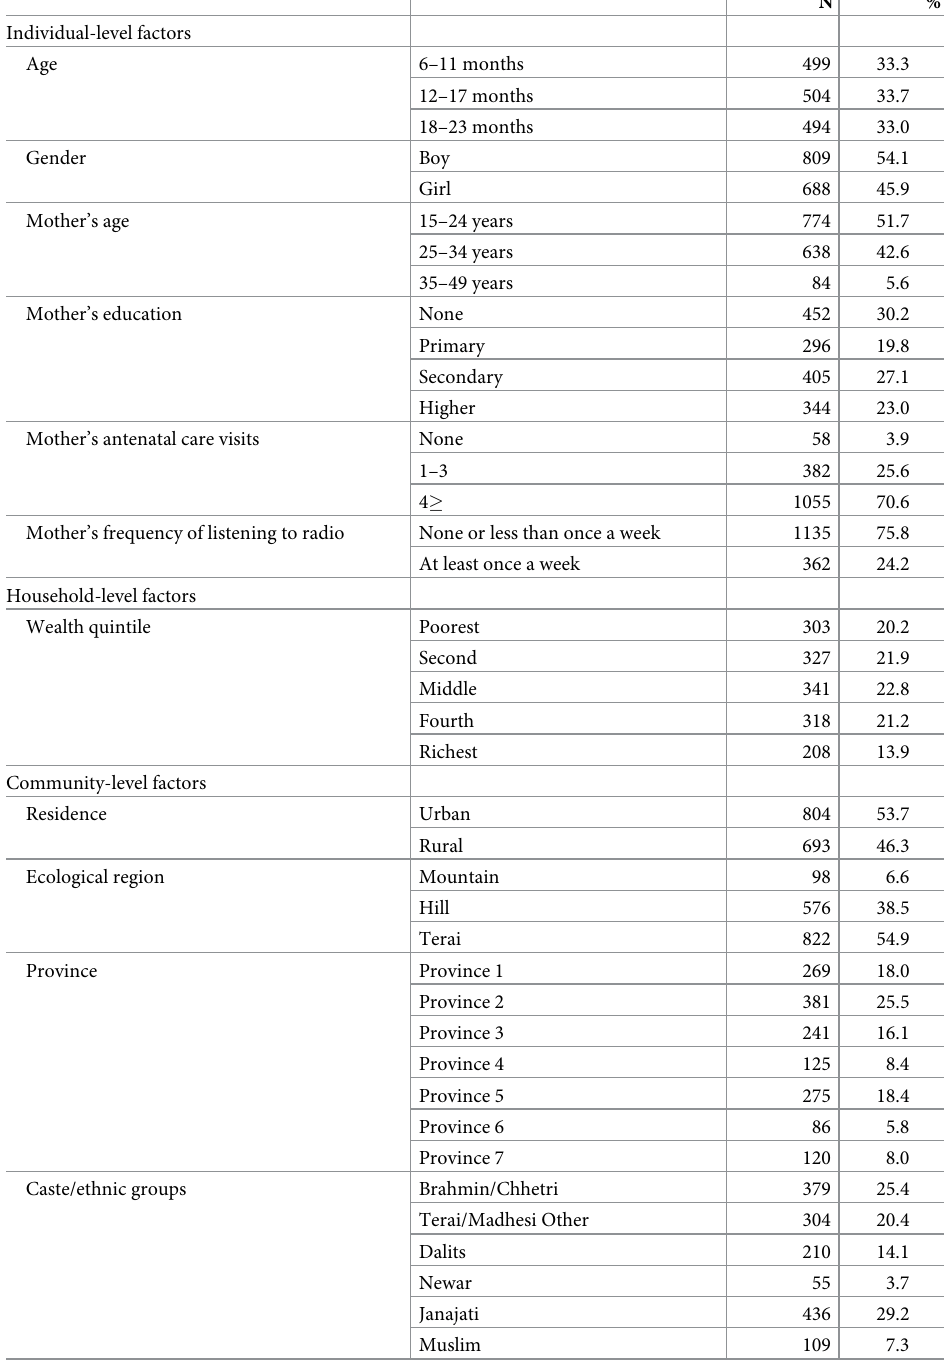
Table 1. Sociodemographic characteristics of Nepalese children aged 6 to 23